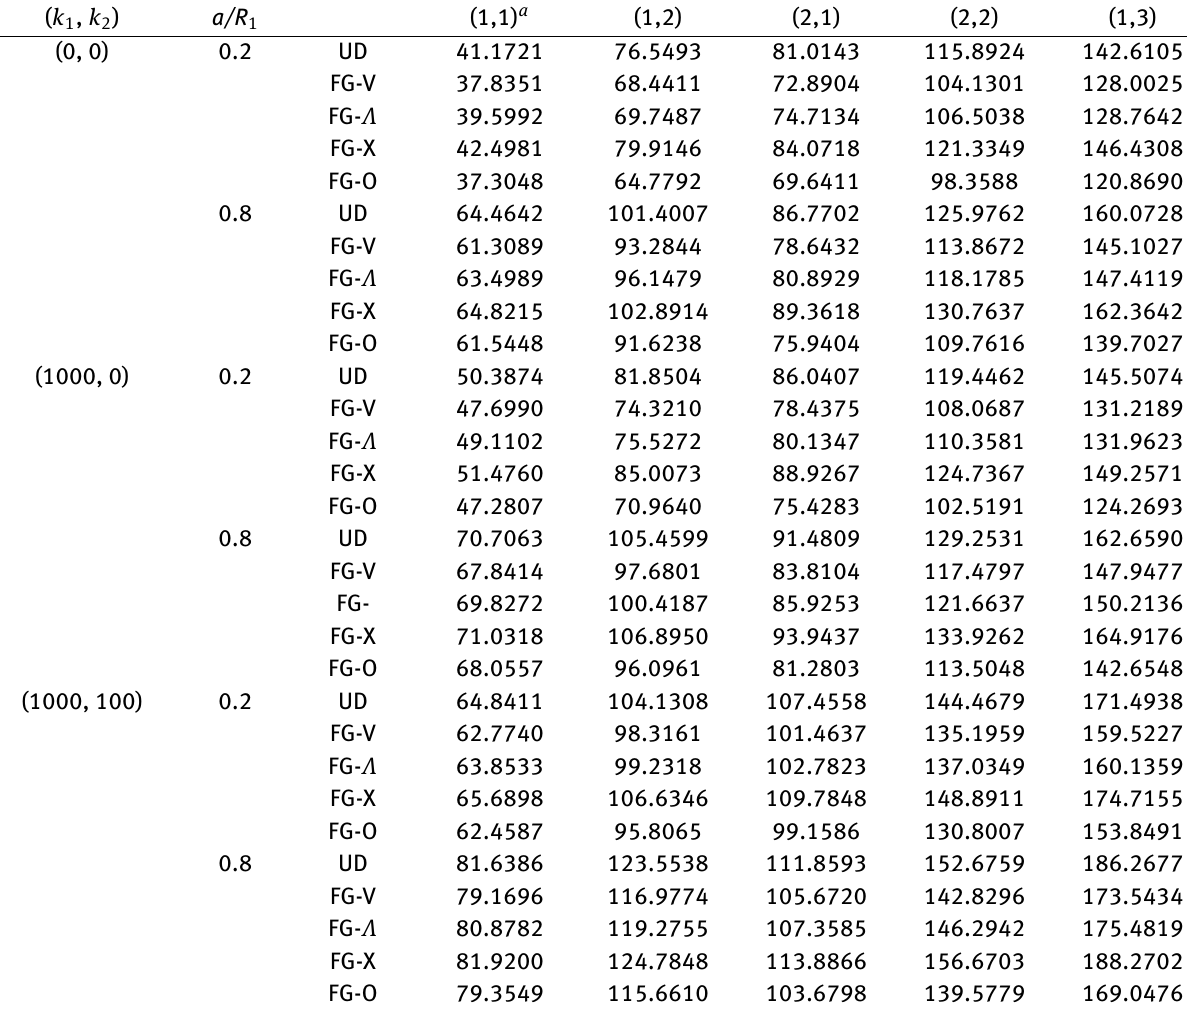
Table 6: Effects of foundation stiffness on the natural frequency ˜ Ω = Ω ( b 2 / h ) √︀ ρ 0 / E 0 of double curved (0/90/0/90/0) S GRC laminated panels. ( a/b = 1, b/h = 20, h = 2 mm, b / R 2 = 0.4, T =